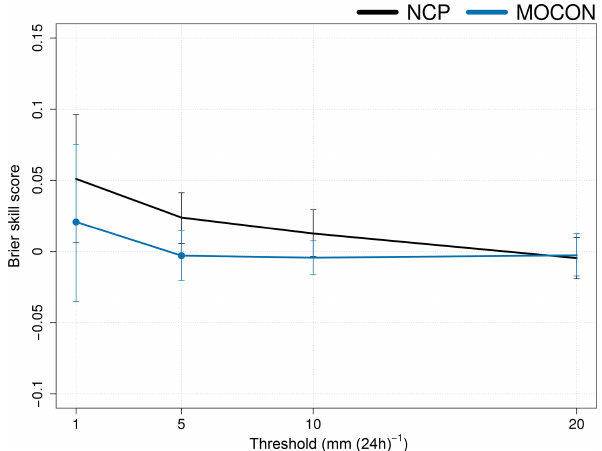
Figure 18. The Brier skill score with respect to the CP ensemble of the NCP (black) and MOCON (blue) ensemble for 24h accumu- lated precipitation at different thresholds. The Brier score is calcu- lated with respect to TRMM observations. The error bars show the 95% confidence interval. Filled circles show where the MOCON BSS is significantly different from the NCP